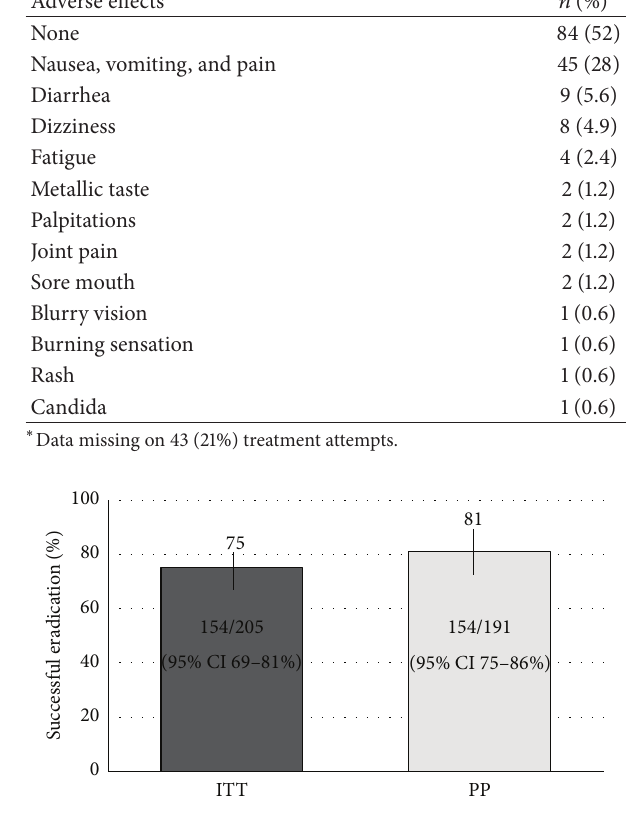
Figure 3: Overall H. pylori eradication for combined 2nd through 6th treatment attempts and including all antibiotic regimens using intention to treat (ITT) and per protocol (PP)